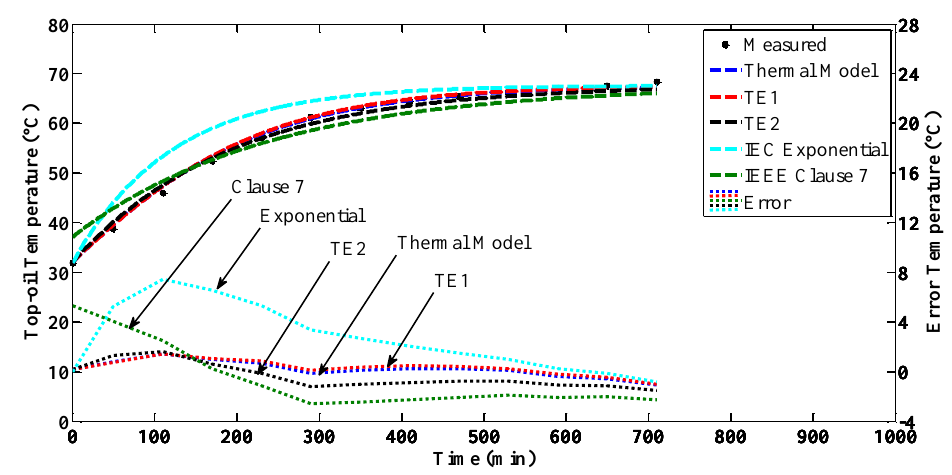
Figure 11. TOT based on different thermal models for TX5.